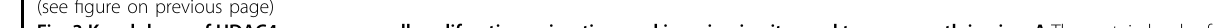
Fig. 3 Knockdown of HDAC4 suppresses cell proliferation, migration, and invasion in vitro and tumor growth in vivo. A The protein levels of HDAC4 were determined by western blotting in 5-8F and S18 cell lines with or without knockdown. GAPDH was used as a loading control. B The proliferation of the indicated cell lines in vitro was determined by CCK8 assays. The data are presented as the means ± SD of three independent experiments. Student ’ s t -test, ** P < 0.01. C The colony formation ability of the indicated cells was determined. The images on the right are representative images. The data are presented as the means ± SD of three independent experiments. Student ’ s t -test, ** P < 0.01. D Cell invasion and migration were determined in the indicated stable cell lines as described in the “ Methods ” section. The images on the right are representative images. The data are presented as the means ± SD of three independent experiments. Student ’ s t -test, ** P < 0.01. E Cell invasion and migration wer e determined in the indicated stable cell lines as described in the “ Methods ” section. The images on the right are representative images. The data are presented as the means ± SD of three independent experiments. Student ’ s t -test, ** P < 0.01. F Weight of orthotopic tumors after the subcutaneous injection of S18-Scr cells and S18-shHDAC4#1&2 cells. The bottom panel shows an image of the tumors. The data are presented as means ± SD. Student ’ s t -test, *** P < 0.001. n represents the number of nude mice in each group. G Representative images of tumors via hematoxylin and eosin (H&E) and immunohistochemical (IHC) staining for HDAC4. Scale bar, 50 µm. H The cell cycle was investigated in 5-8F and S18 cells with or without HDAC4 knockdown by fl ow cytometry. The data are presented as the means ± SD of three independent experiments. Student ’ s t -test, * P < 0.05. I , J The relative mRNA and protein levels of EMT-related genes were determined by qRT-PCR (left) and western blotting (right), respectively, in the indicated stable lines. GAPDH and β -actin were used as loading controls. The data are presented as the means ± SD of three independent experiments. Student ’ s t -test, ** P <